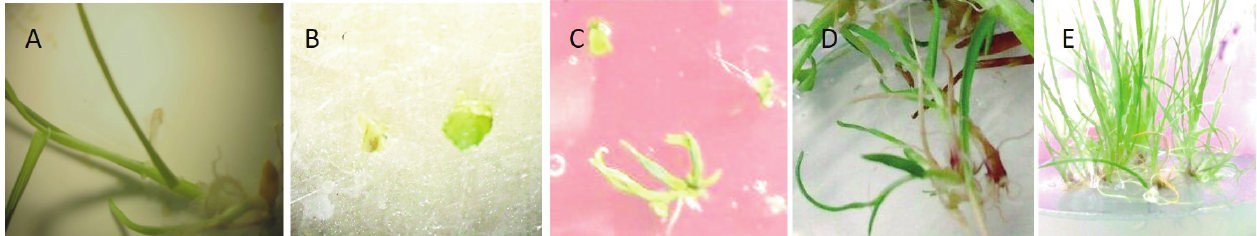
Fig. 3 - Steps of meristem tip culture. A) Ten days old seedling. B) Isolated meristem tips. C) Meristem tip cultured on MS medium.